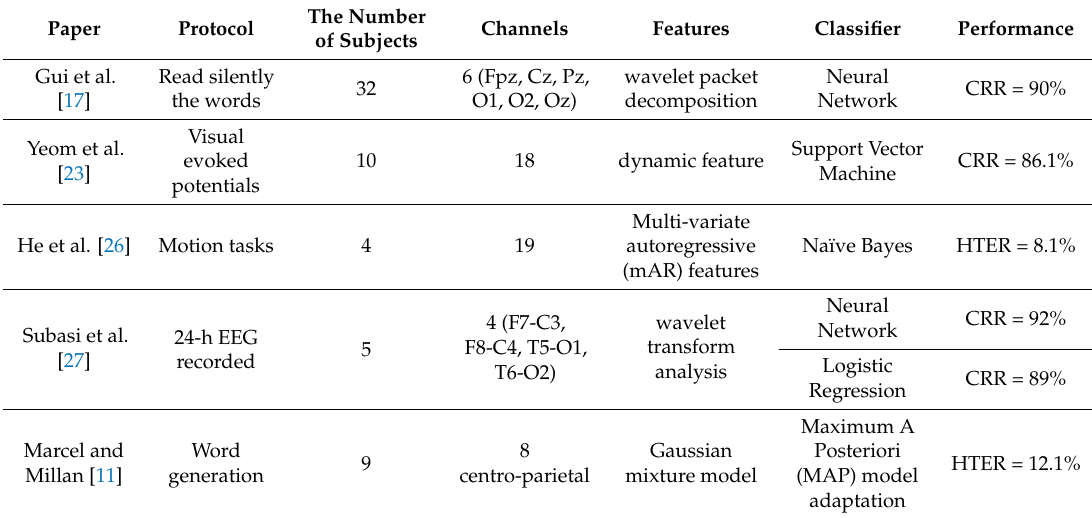
Table 3. Overview of some classic EEG schemes based on biometric systems. CRR: correct recognition rate, HTER: half total error